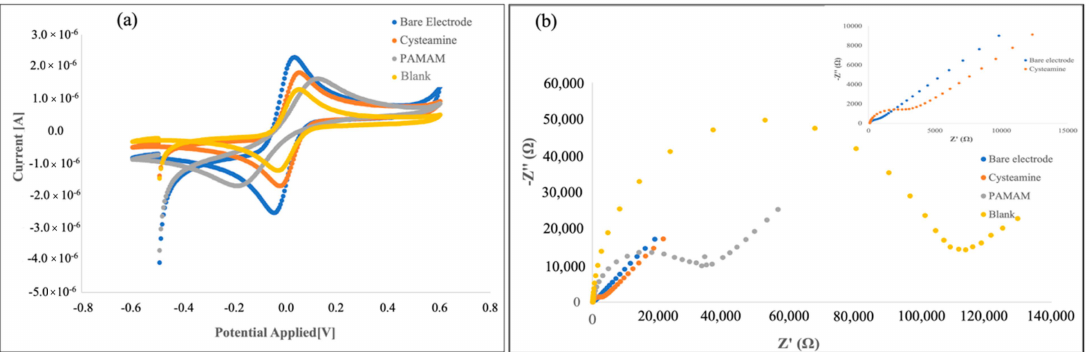
Figure 2. Cyclic voltammograms ( a ) and Nyquist plots ( b ) after each step of DON immunosensor construction. Inset: Nyquist plots of bare and cysteamine electrode.